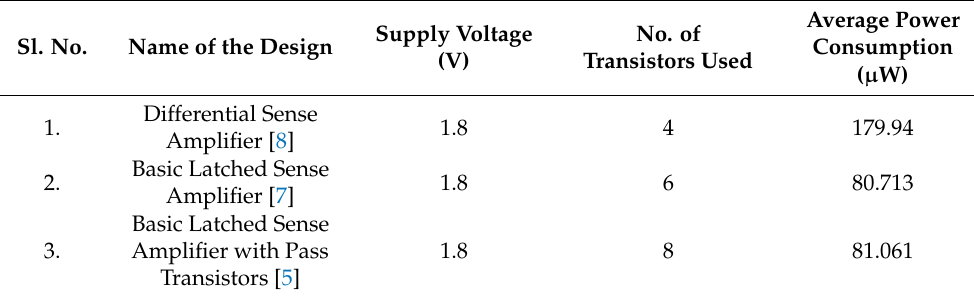
Table 2. Comparison of average power consumption with supply voltage and their transistor sizing for all three conventional